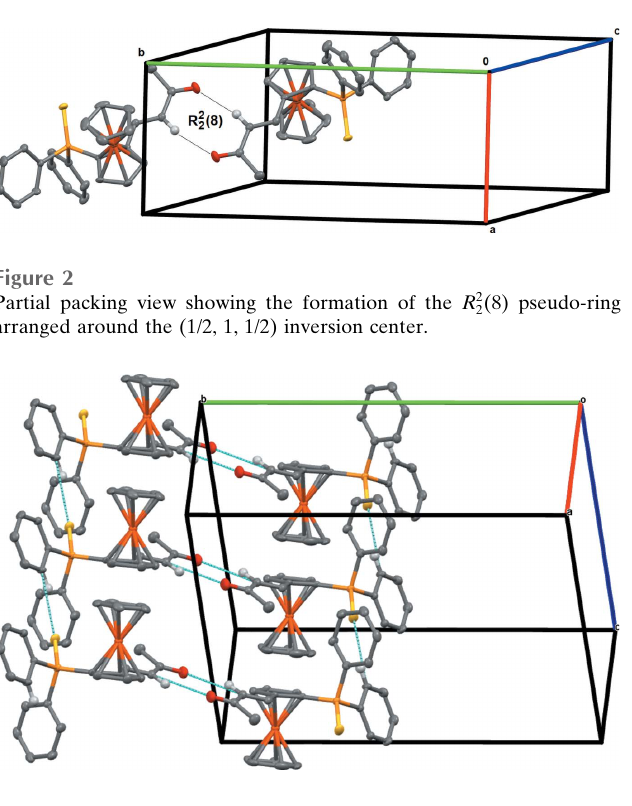
Figure 3 Partial packing view showing the formation of the ribbon parallel to the (011) plane.